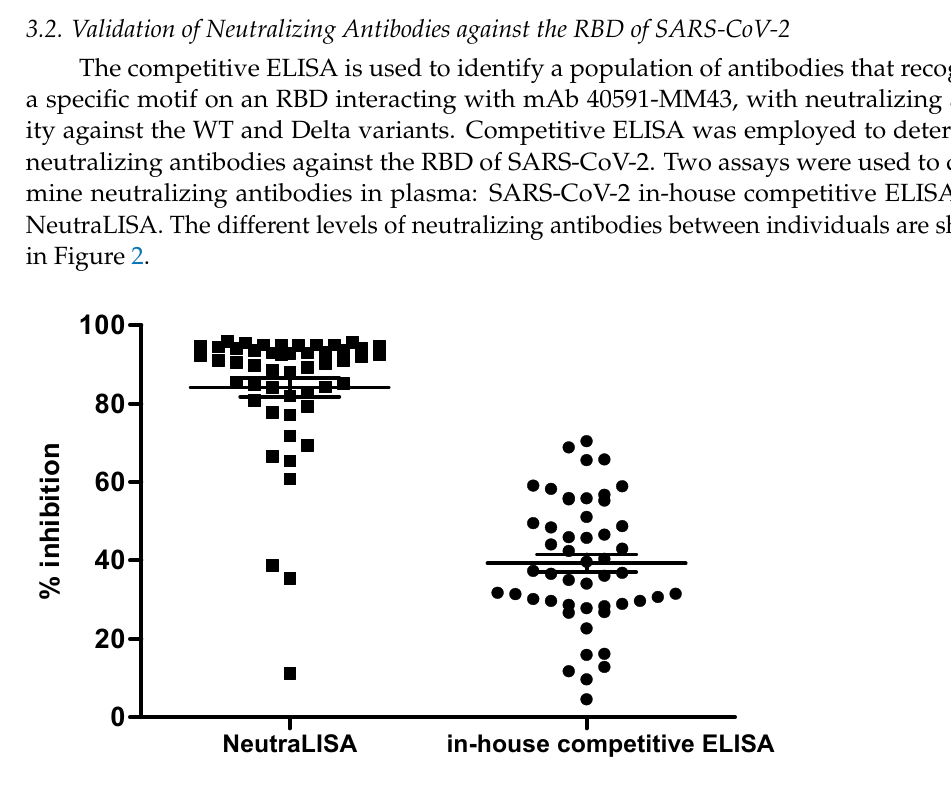
Figure 1. IgG antibodies against the RBD of SARS-CoV-2 levels in plasma samples, collected at 14 days post 3rd vaccination with BNT162b2 ( n = 50), were measured by ARCHITECT i System (Abbott, Ireland).